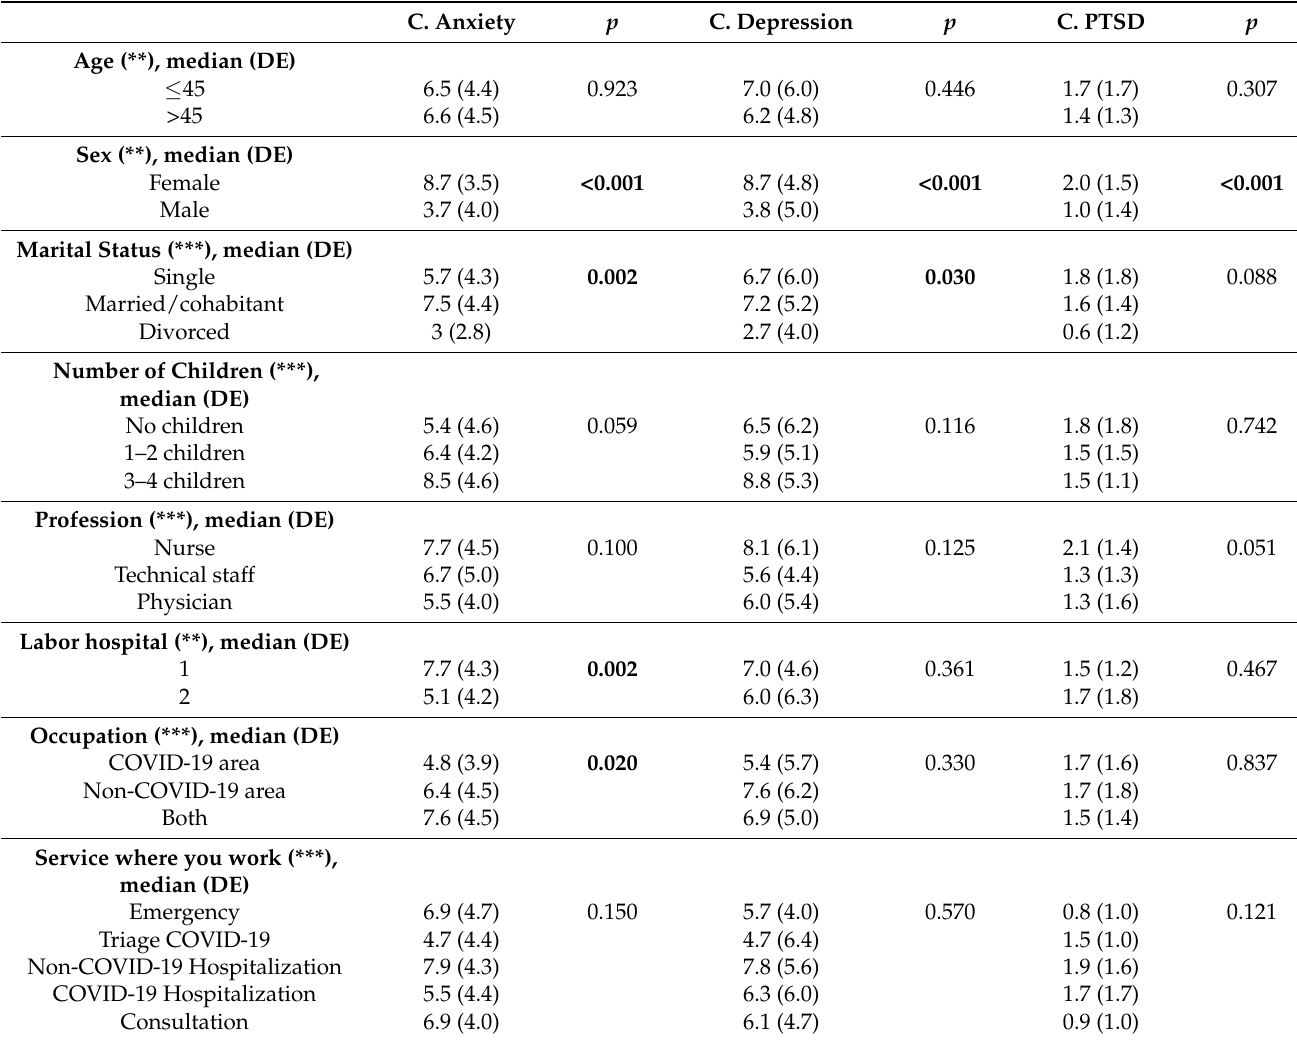
Table 2. Bivariate analysis with respect to the anxiety, depression, and PTSD scores